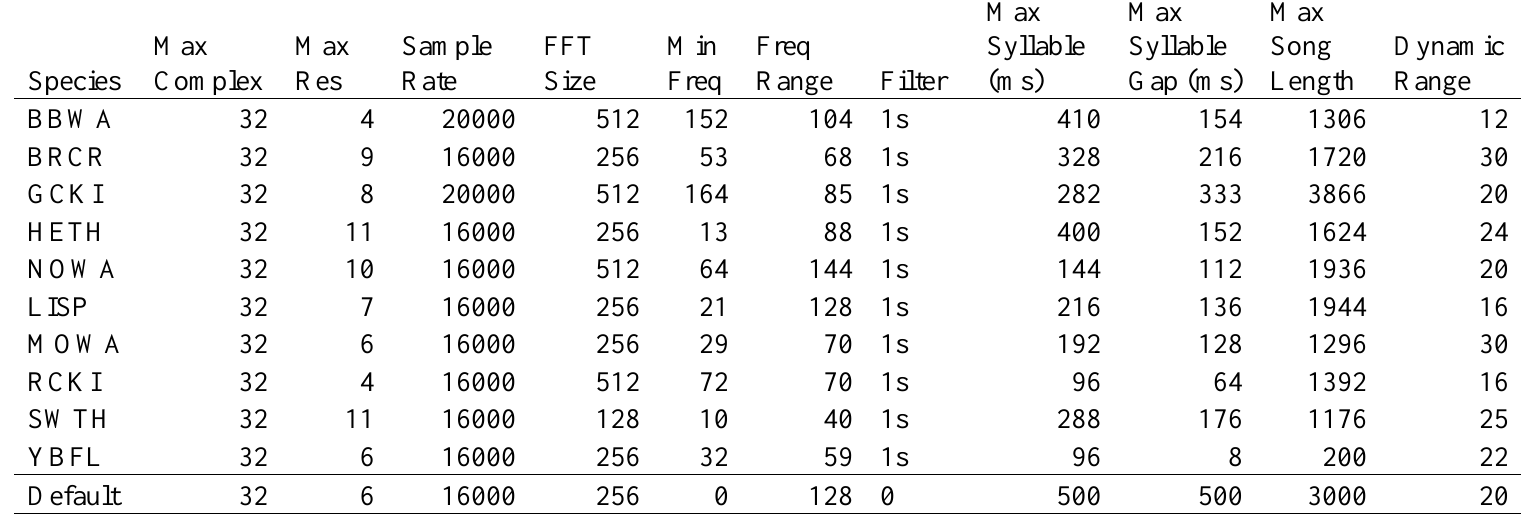
Table A1.2: Parameter values for each of 10 song recognizers. See text above for descriptions of the parameters.